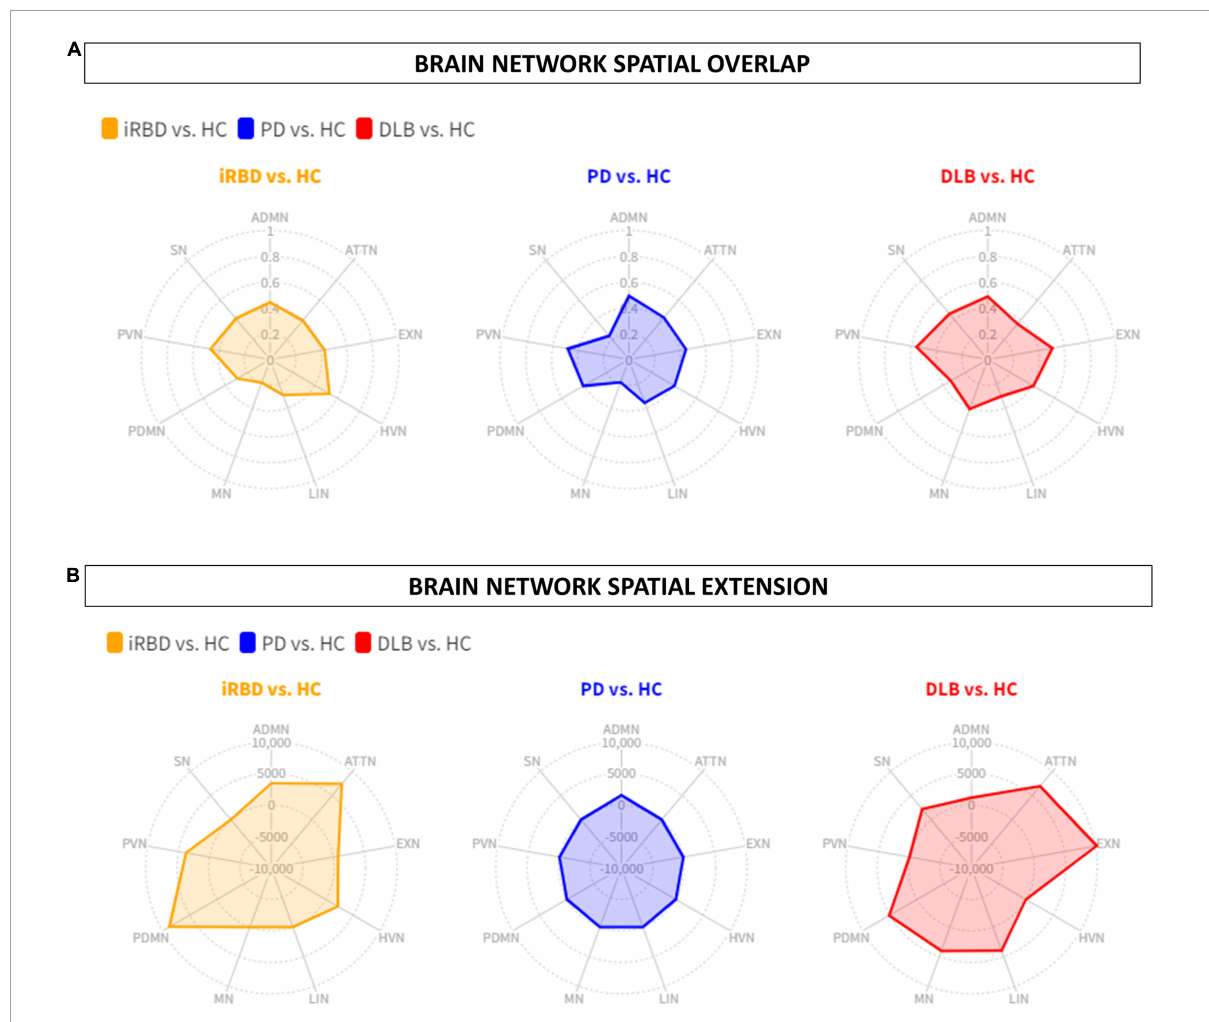
FIGURE2 Brain networks spatial overlap and extension. (A) The spatial overlap between HC and iRBD (orange), PD (blue), and DLB (red) in the ADMN, PDMN, ATTN, EXN, LIN, HVN, PVN, MN, SN, is expressed by DC. (B) The spatial extension of all networks in RBD (orange), PD (blue), and DLB (red) compared to HC, expressed as the difference between HC and each clinical group ( (cid:49) ). iRBD, isolated REM sleep behavior disorder; PD, Parkinson’s disease; DLB, dementia with Lewy Bodies; HC, healthy controls; ADMN, anterior default mode network; ATTN, attentive network; EXN, executive network; HVN, high visual network; LIN, limbic network; MN, motor network; PDMN, posterior default mode network; PVN, primary visual network; SN, somatosensory